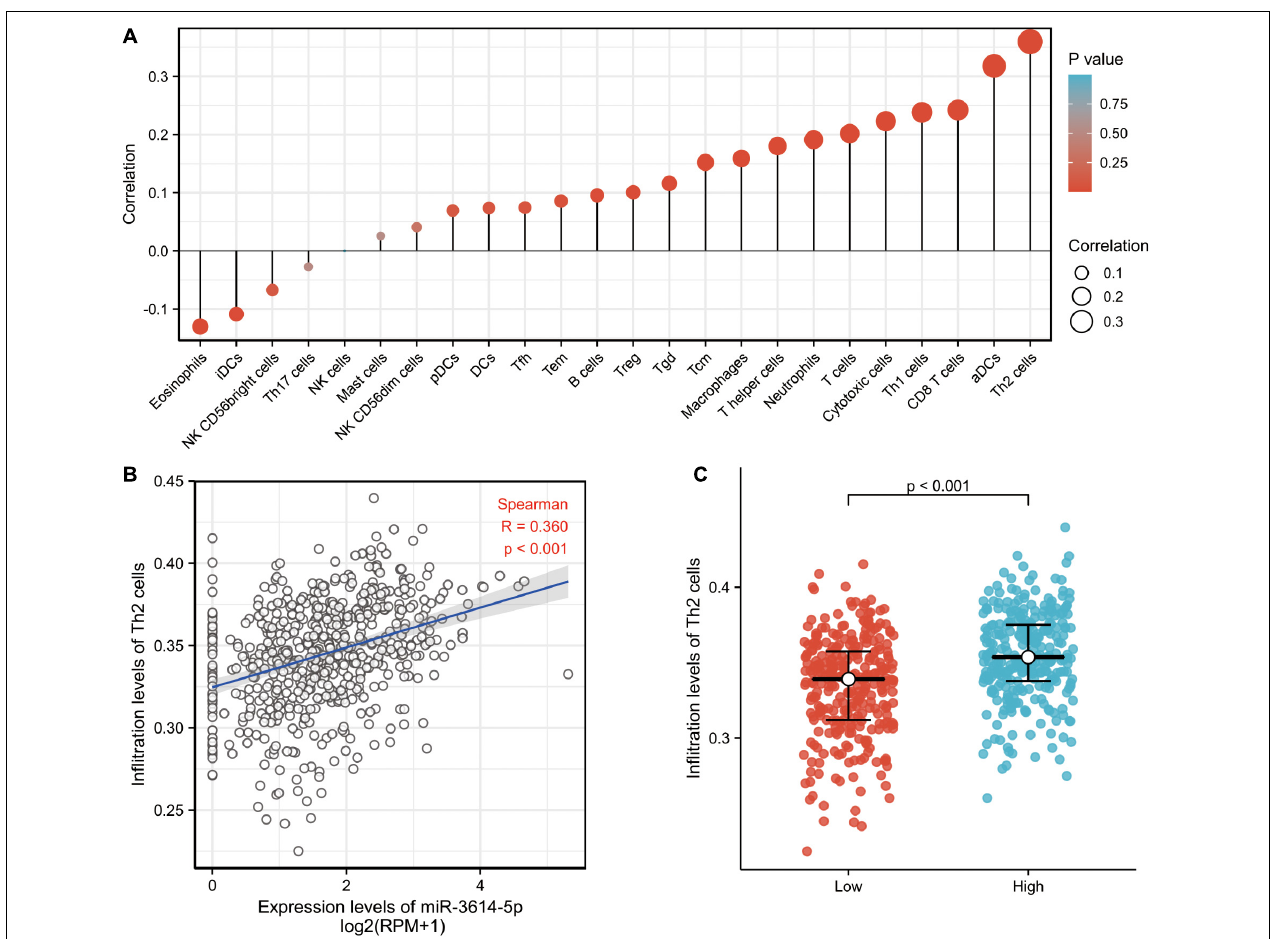
FIGURE 4 | The correlation between miR-3614-5p expression and immune invitation. (A) The forest plot shows the correlation between miR-3614-5p expression and immune cell subsets. (B) Correlation between the relative enrichment score of Th2 cells and the expression level (TPM) of miR-3614-5p. (C) Difference in Th2 cells infiltration level between miR-3614-5p high and low expression